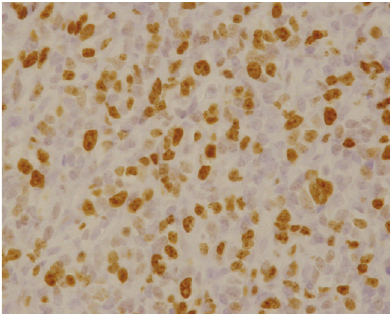
Figure 7: The specimen resected in 2007. More cells were stained by Ki-67. Ki-67 labeling index was